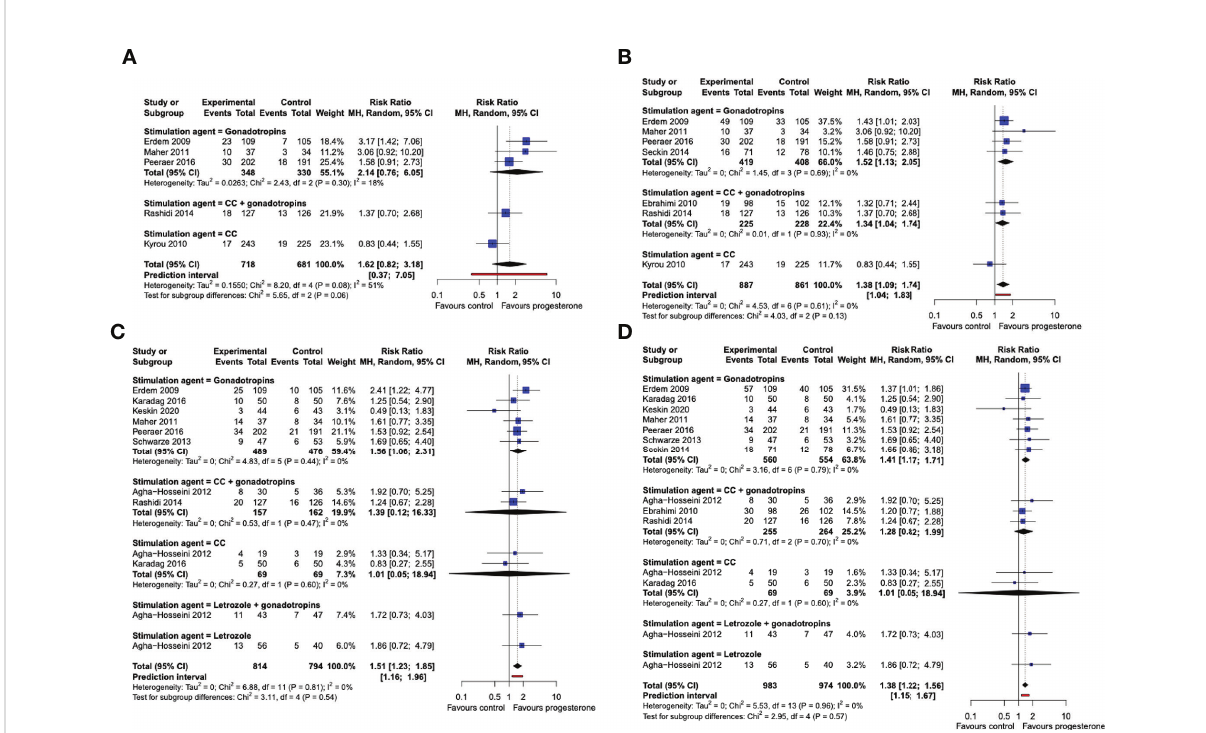
FIGURE 5 Subgroup analysis by stimulation drug. Comparison: progesterone luteal phase support versus placebo or no intervention. (A) Forest plot of live birth, single/ fi rst cycle. (B) Forest plot of live birth, cumulative over all study cycles. (C) Forest plot of clinical pregnancy, single/ fi rst cycle. (D) Forest plot of clinical pregnancy, cumulative over all study cycles. Subgroups by stimulation agent. CC, clomiphene citrate; MH, Mantel- Haenszel; CI, con fi dence